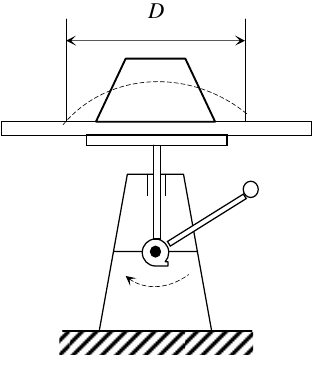
Fig 4. Flow table for determining the workability of freshly mixed